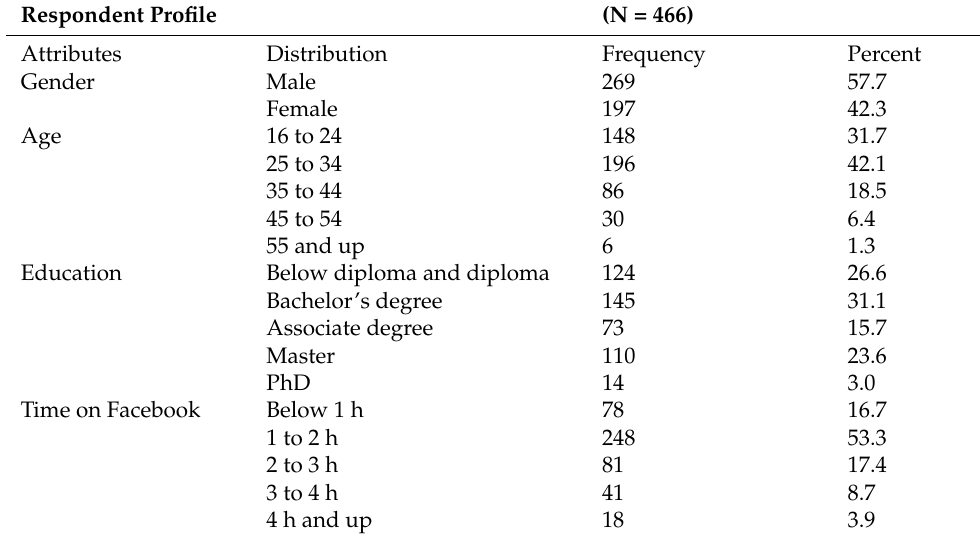
Table 1. Demographic